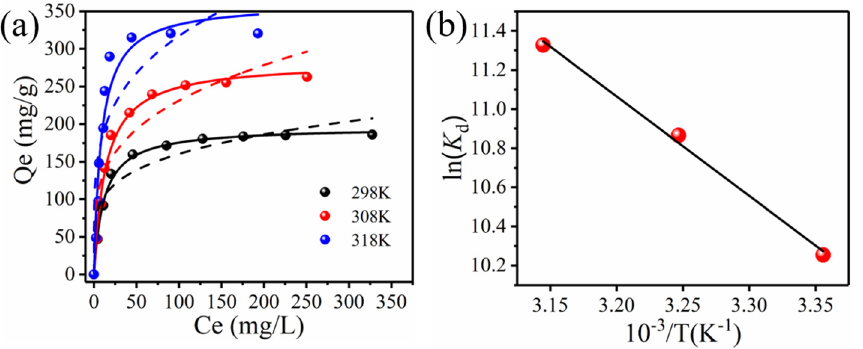
Figure 4. ( a ) isothermal adsorption fitting curve of Sr 2+ adsorption using 1V: 9Mn at different temperatures and concentrations (solid lines is Langmuir model, dashed lines is Freundlich model), ( b ) thermodynamic investigations of 1V: 9Mn.